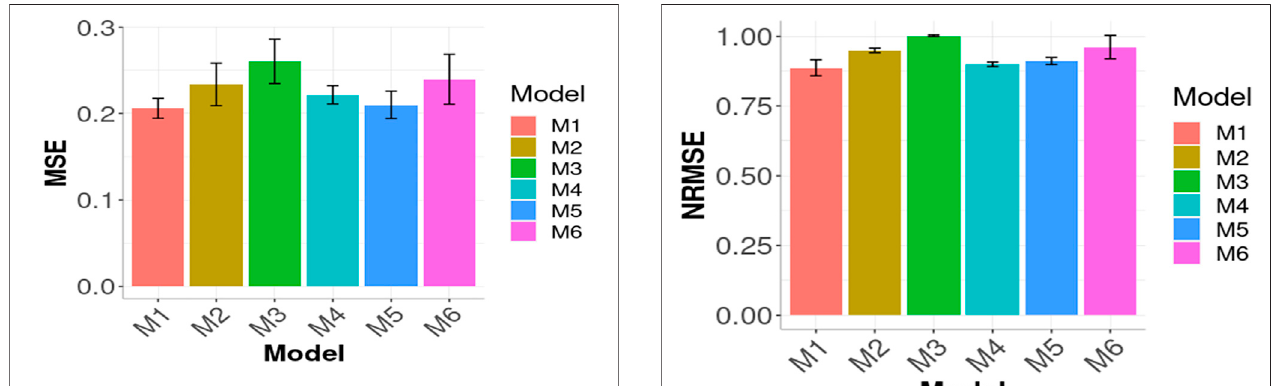
FIGURE 3 | Prediction performance in terms of Mean Squared Error of prediction of the six models (M1, M2, M3, M4, M5, M6) across environment (Global) in Maize data. M1 denotes the generalized boosted machine model, M2denotesthegeneralizedlinearmodel,M3denotesthesupportvector machine model, M4 denotes the random forest model, M5 denotes the Bayesianregressionmodel and M6denotes thedeep neural networks model.